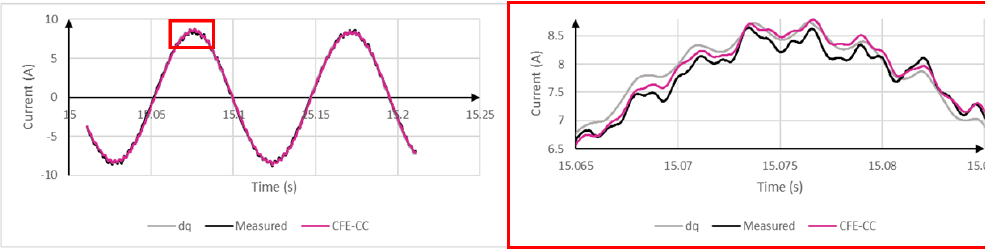
Figure 8. Rotor current in winding a r during load operation, enlarged on right